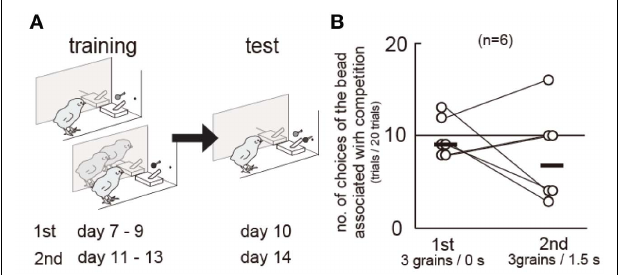
FIGUREA2 | Biased choices were not found between the colored bead associated with competition and that with no-competition. Data obtained from a group of chicks ( n = 6) are shown. (A) Experimental procedure of training and test.The subject chick was separated from the accompanying chicks by a transparent Plexiglas, so that actual interference of food reward did not occur. In the first set of blocks, a blue (or green) bead was associated with competition and 3 grains after Δ = 0s, and a green (or blue) bead was associated with no-competition and 3 grains after Δ = 0s.We had confirmed that chicks distinguished these two colors in experiment 1. Chicks learned this association from day 7 to day 9, and were tested between two colors (day 10). In the second set of blocks, similarly, colored beads were associated with food both after Δ = 1.5 s. Chicks relearned from day 11 to day 13), and were tested (day 14).The color assignment counterbalanced in the group ( n = 3 for each). (B) Numbers of choices of the colored bead associated with competition were recorded in the first and the second sets. Connected pair of circles denote each individual chick, and short horizontal bars indicate the median of the group.